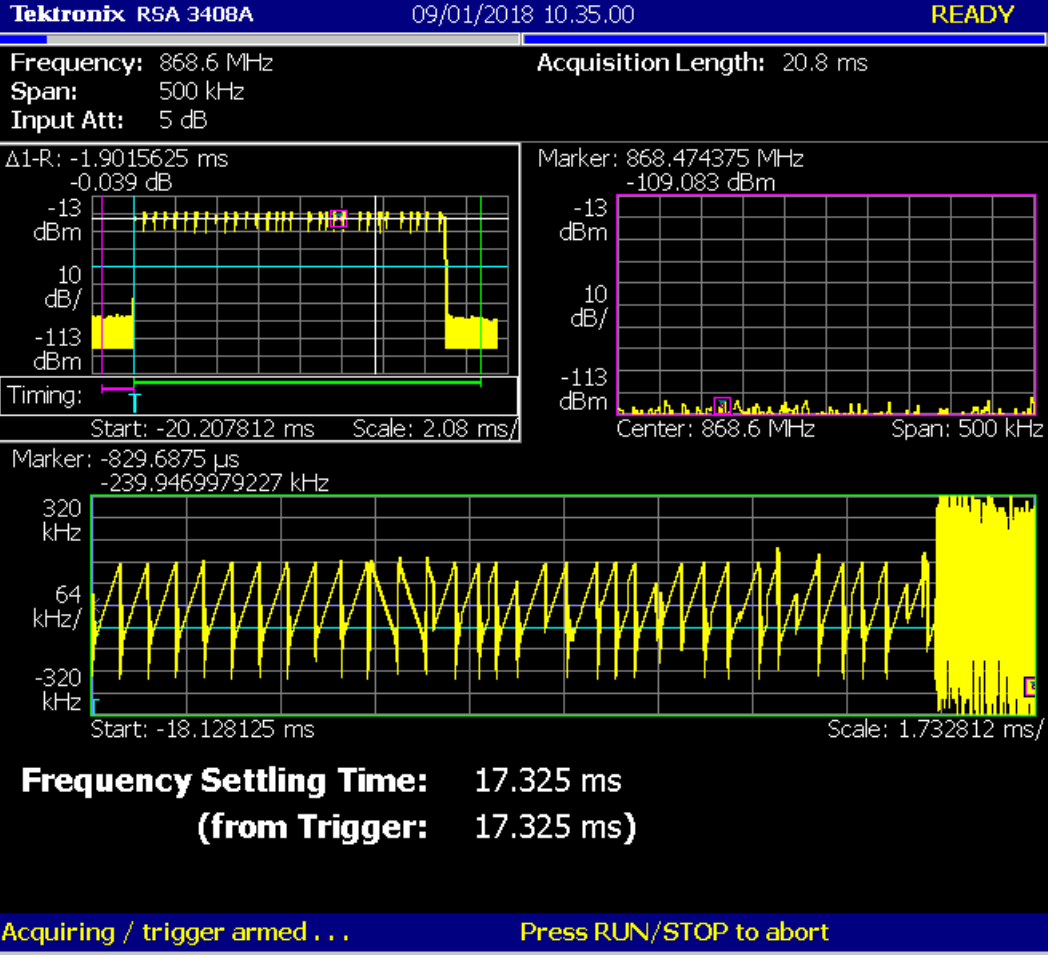
Figure 9. Time–frequency diagram of a LoRa packet with a duration of 15.46